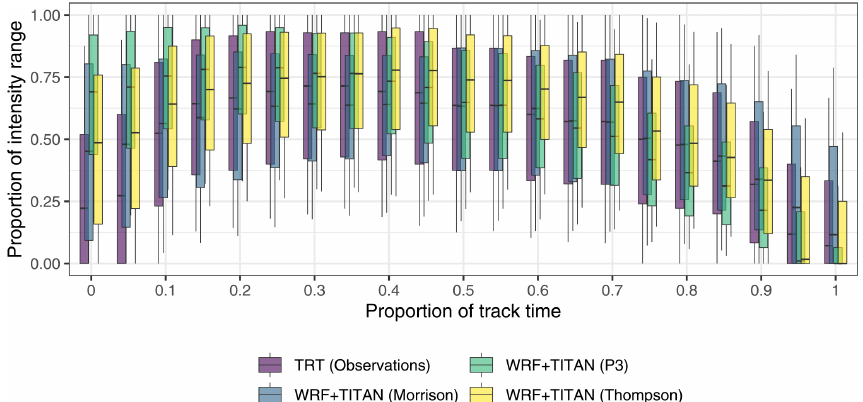
Figure 14. Relative life cycle of storm cells. Vertical bars show distributions, with the middle marker showing the median, the coloured bar showing the IQR, and vertical lines showing the 10th to 90th percentile